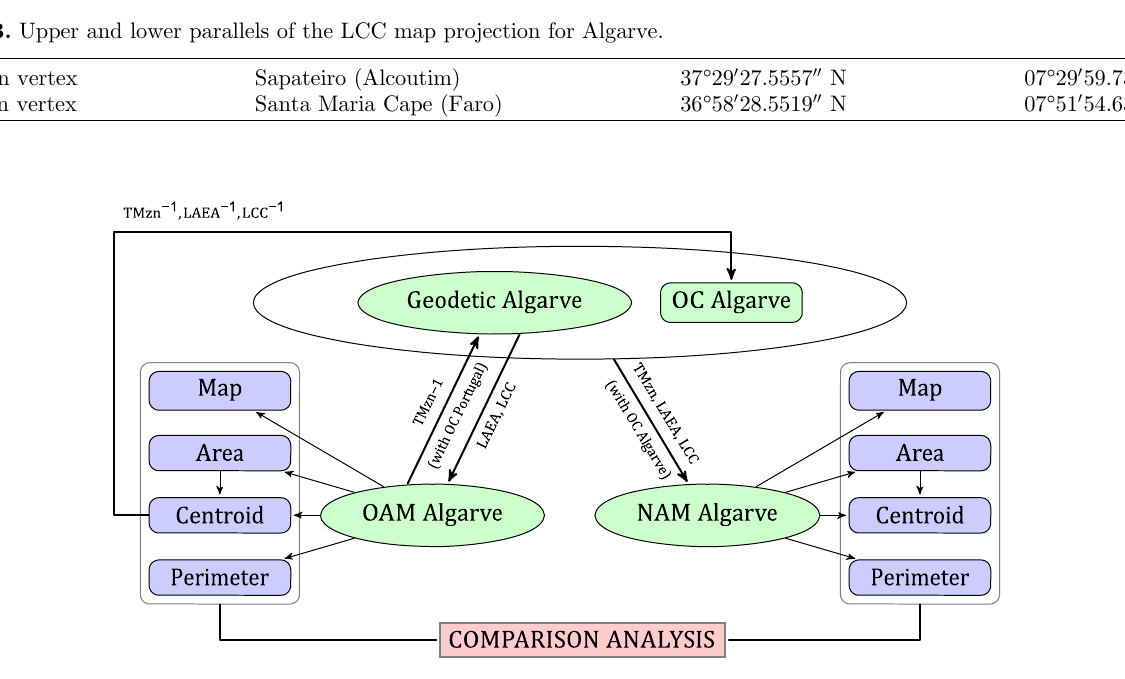
Diagram 2. Comparison analysis of the OAM Algarve with the NAM